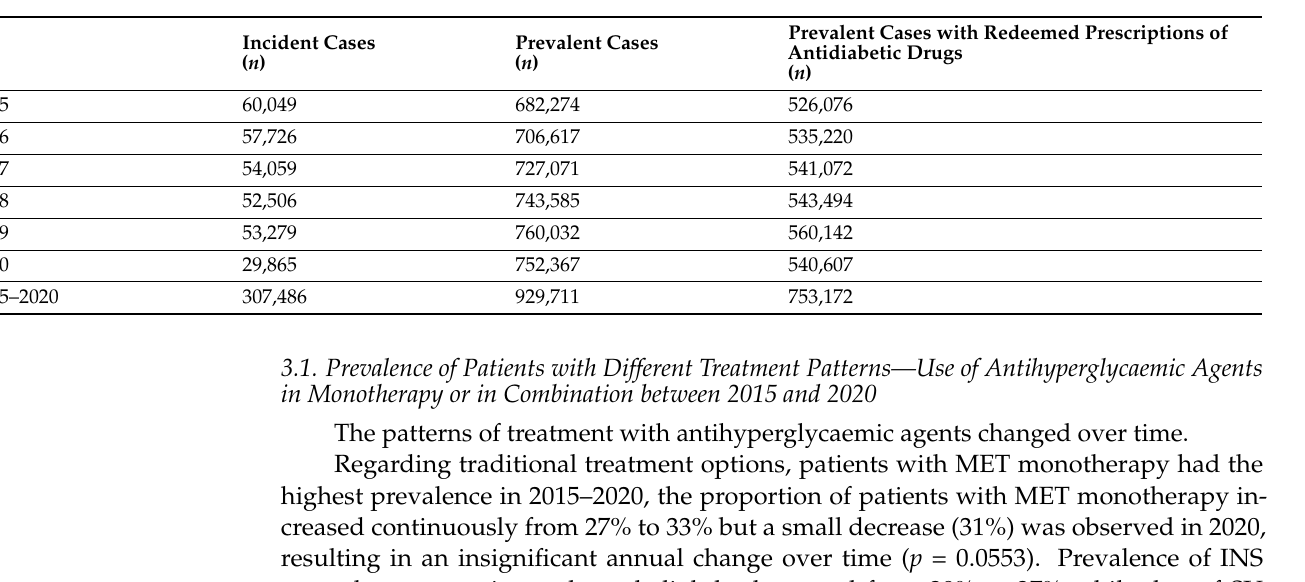
Table 1. Patients with type 2 diabetes mellitus (T2DM): incident and prevalent cases (crude numbers) in the central database between 2015 and 2020 (reference period: 2013–2014).